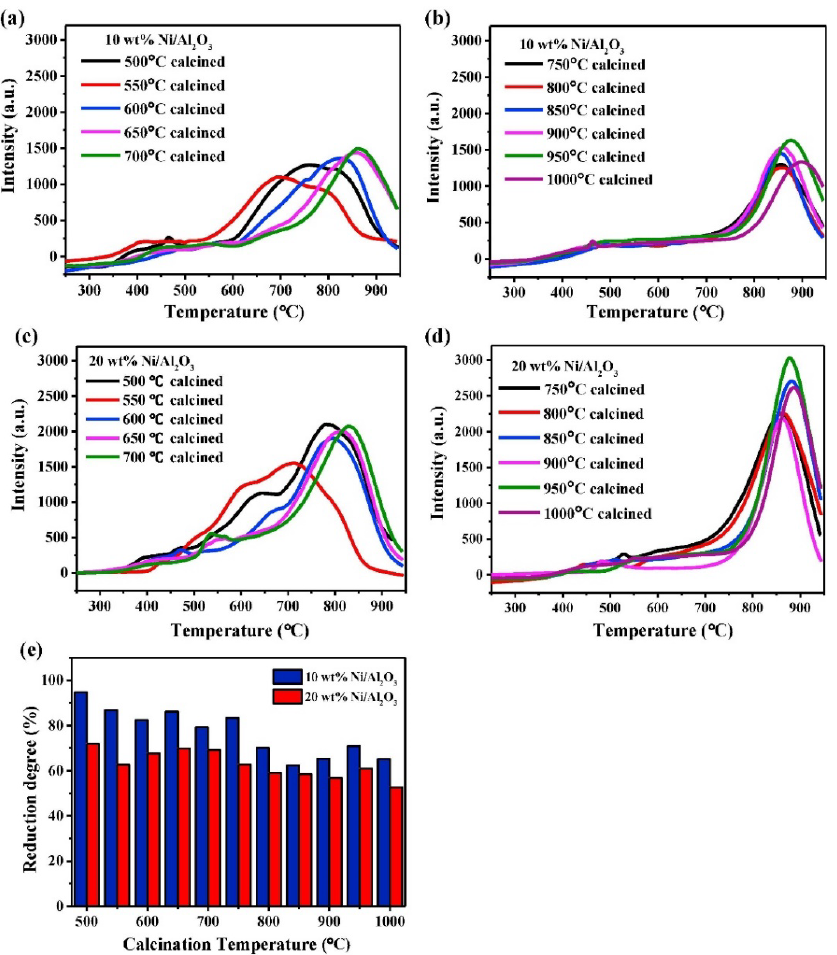
Figure 2. ( a – e ) TPR and reduction degree of Ni/Al 2 O 3 with different loading and different calcination temperature. Reprinted with permission from [56], copyright 2018, Elsevier.